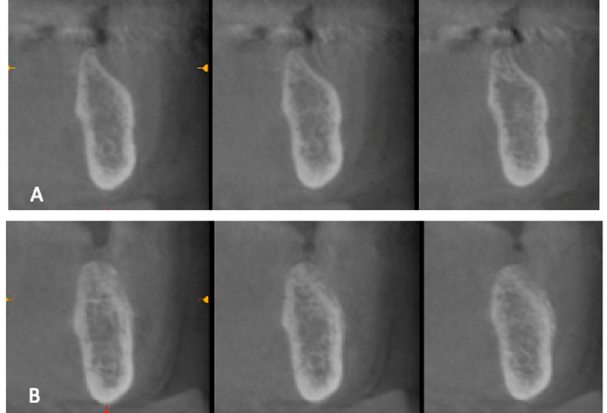
Figure 1. Radiographic investigation before surgery ( A ) and after the healing time ( B ) before im-